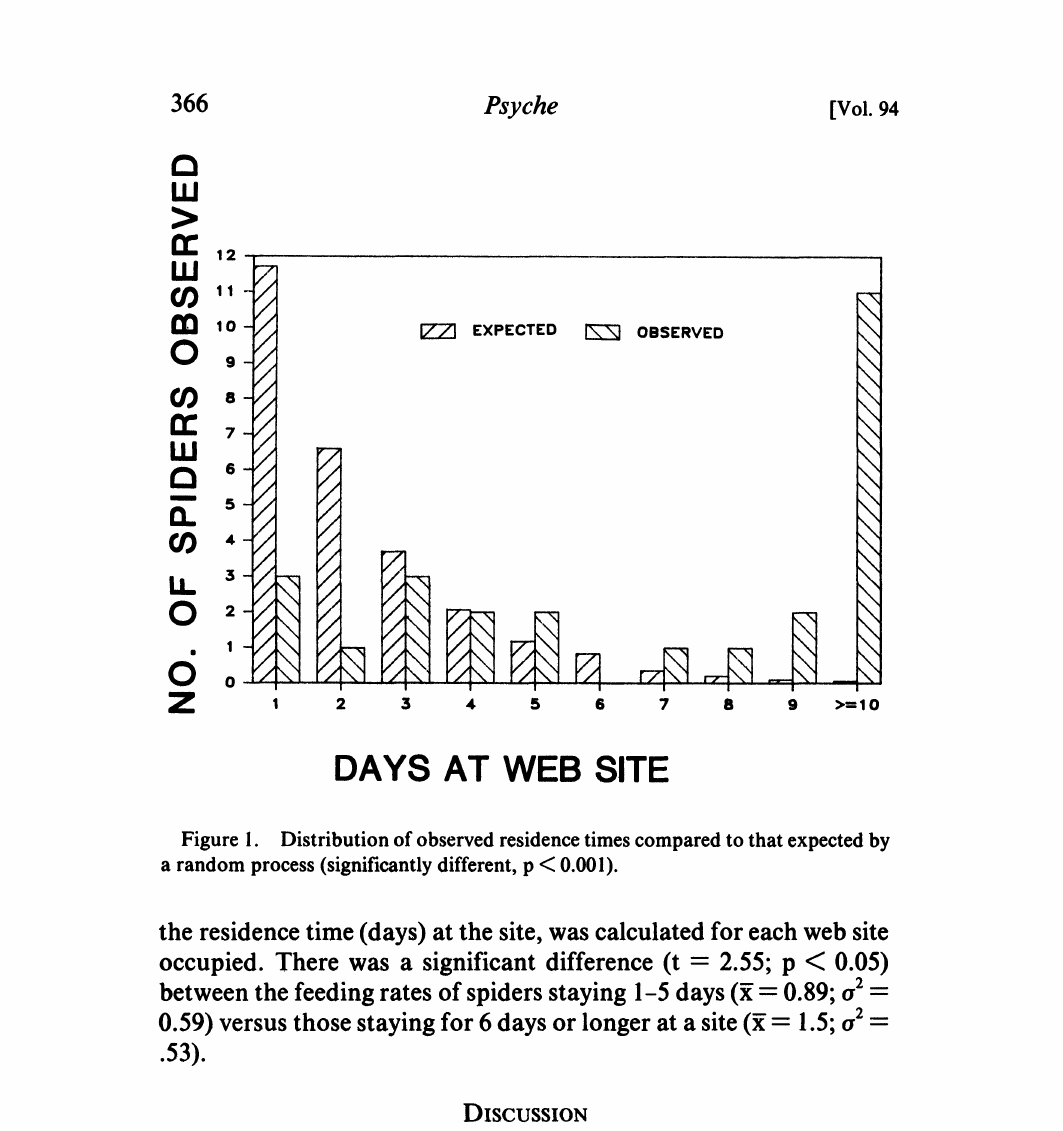
Figure 1. Distribution of observed residence times compared to that expected by a random process (significantly different, p <